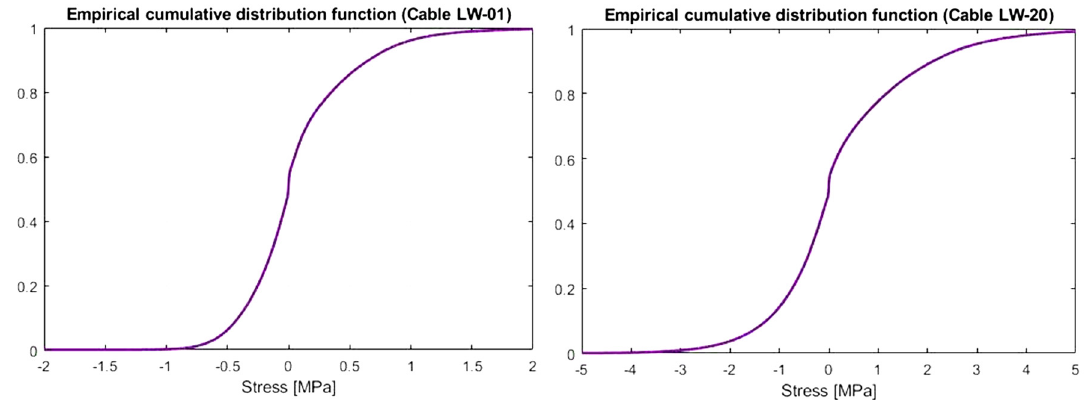
Figure 20. Empirical cumulative distributions for stress changes in the shortest (LW-01) and longest cable (LW-20).